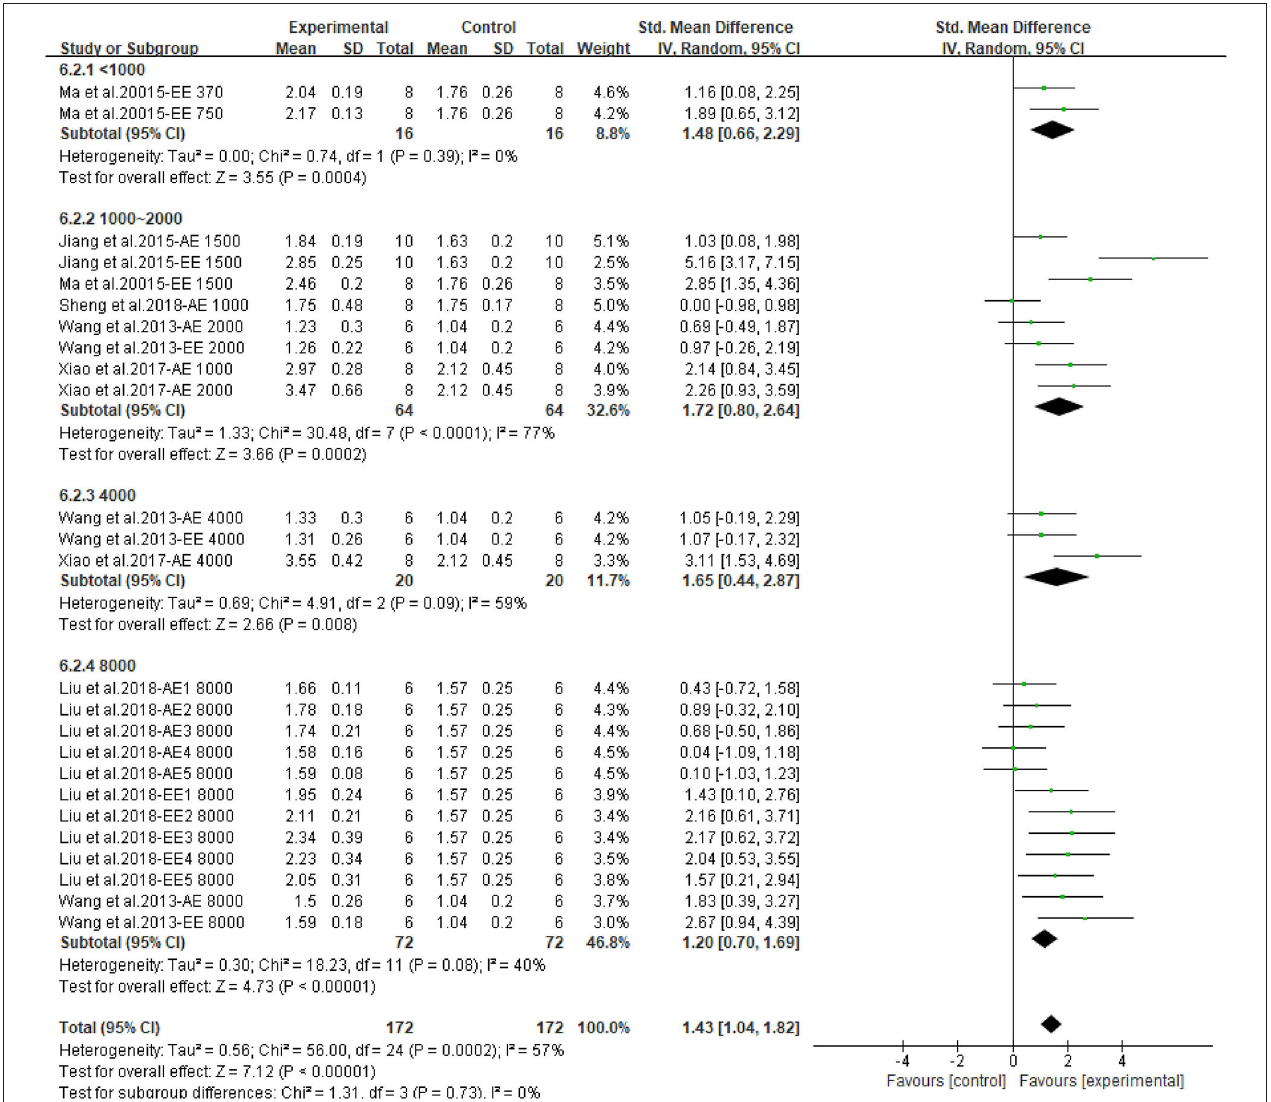
FIGURE 8 | Forest plot for the effect of Cyclocarya paliurus (CP) on high-density lipoprotein levels in animal models. Subgroup analysis was performed according to doses.